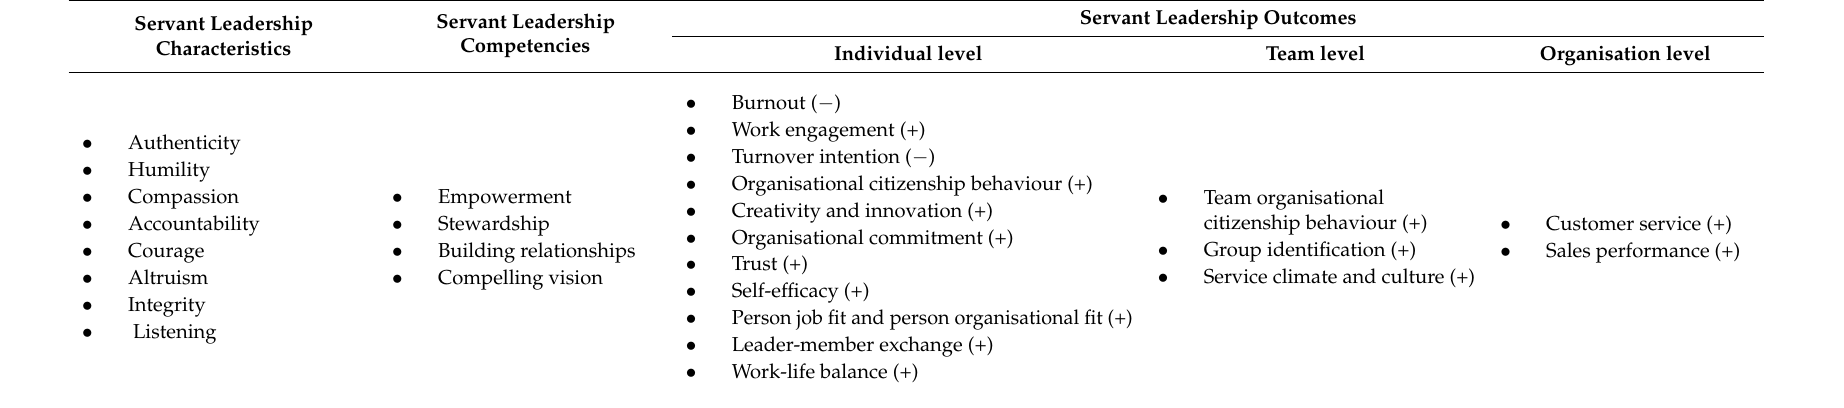
Table 3. Summary of